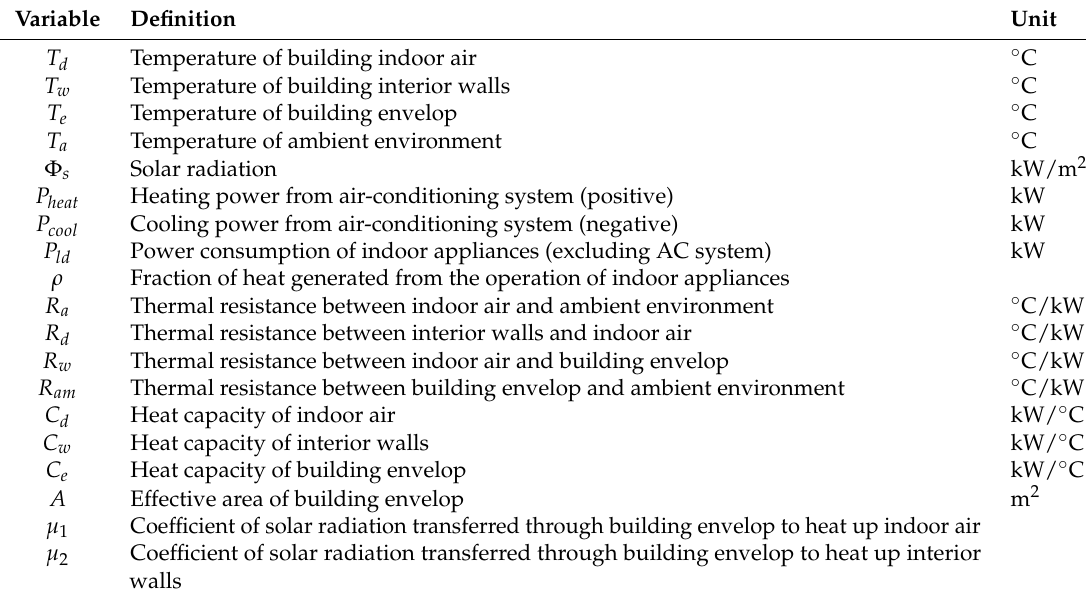
Table 1. Variables in the thermal